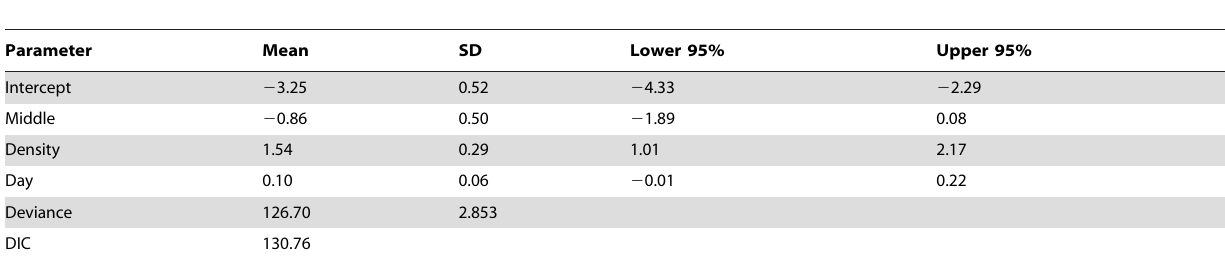
Table 4. Parameter estimates (Mean), standard deviations (SD), and 95% credible intervals for the logistic regression model relating African jewelfish eDNA detections to pond- and sample-level factors.